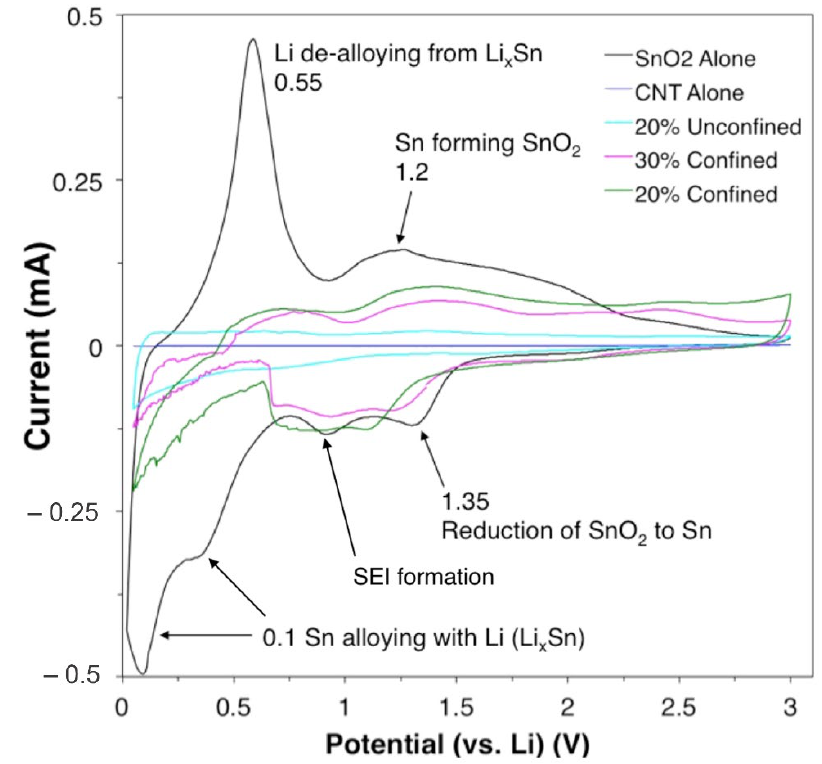
Figure 5. CV curves for control group and experimental samples.